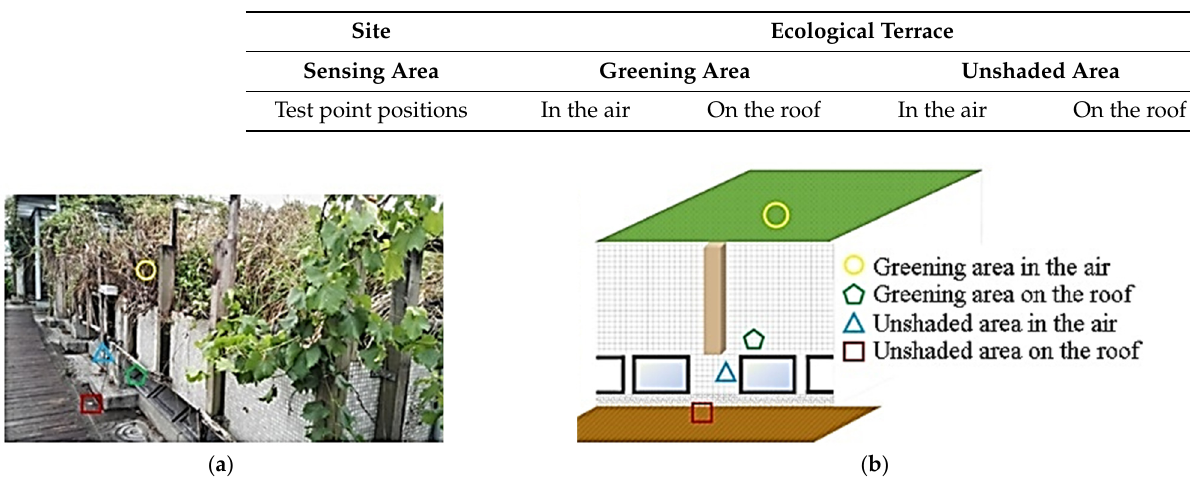
Figure 3. ( a ) Photograph and ( b ) schematic of the sensing positions on the ecological terrace.